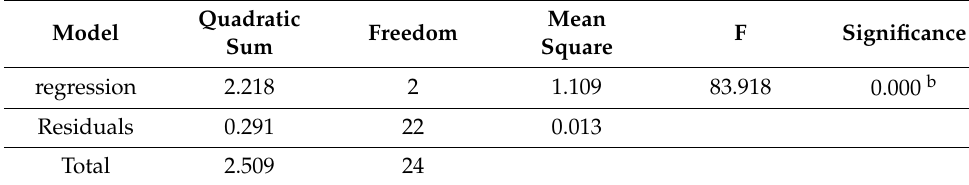
Table 5. Analysis of variance.